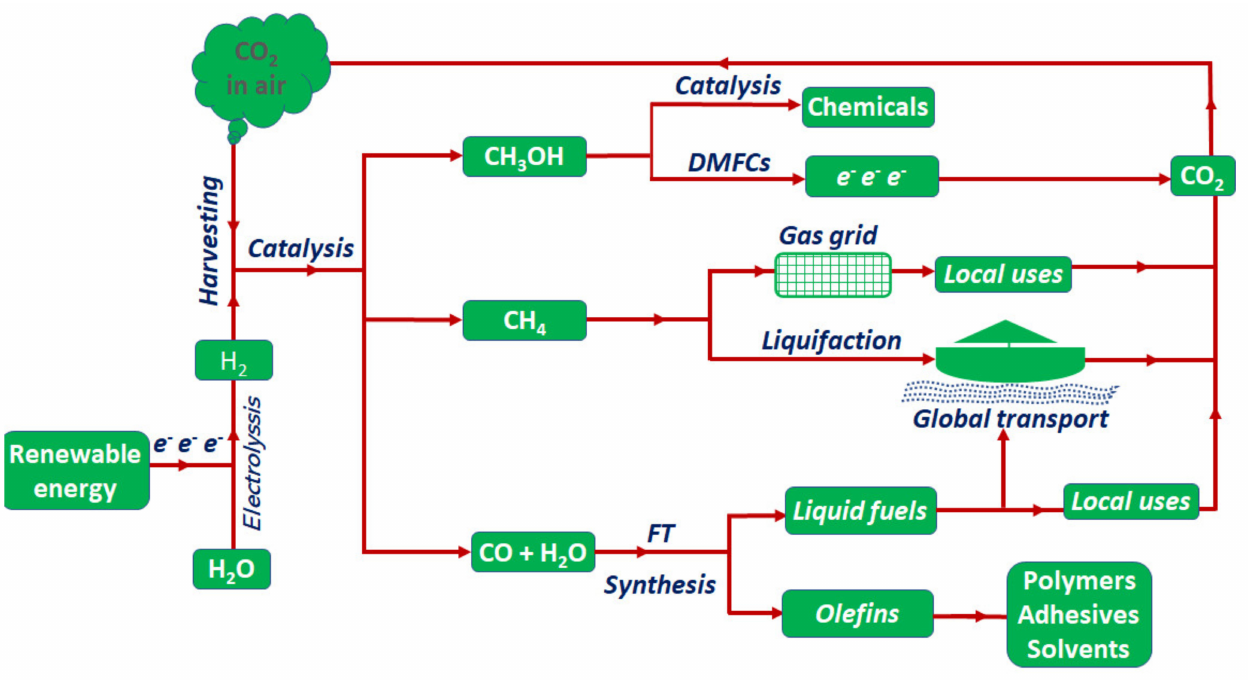
Figure 1. Schematic representation of the pathways for the conversion of carbon dioxide harvested from air using green hydrogen produced form renewable energy (DMFCs: direct methanol fuel cells; gas grid: the natural gas grid; FT: Fischer Tropsch